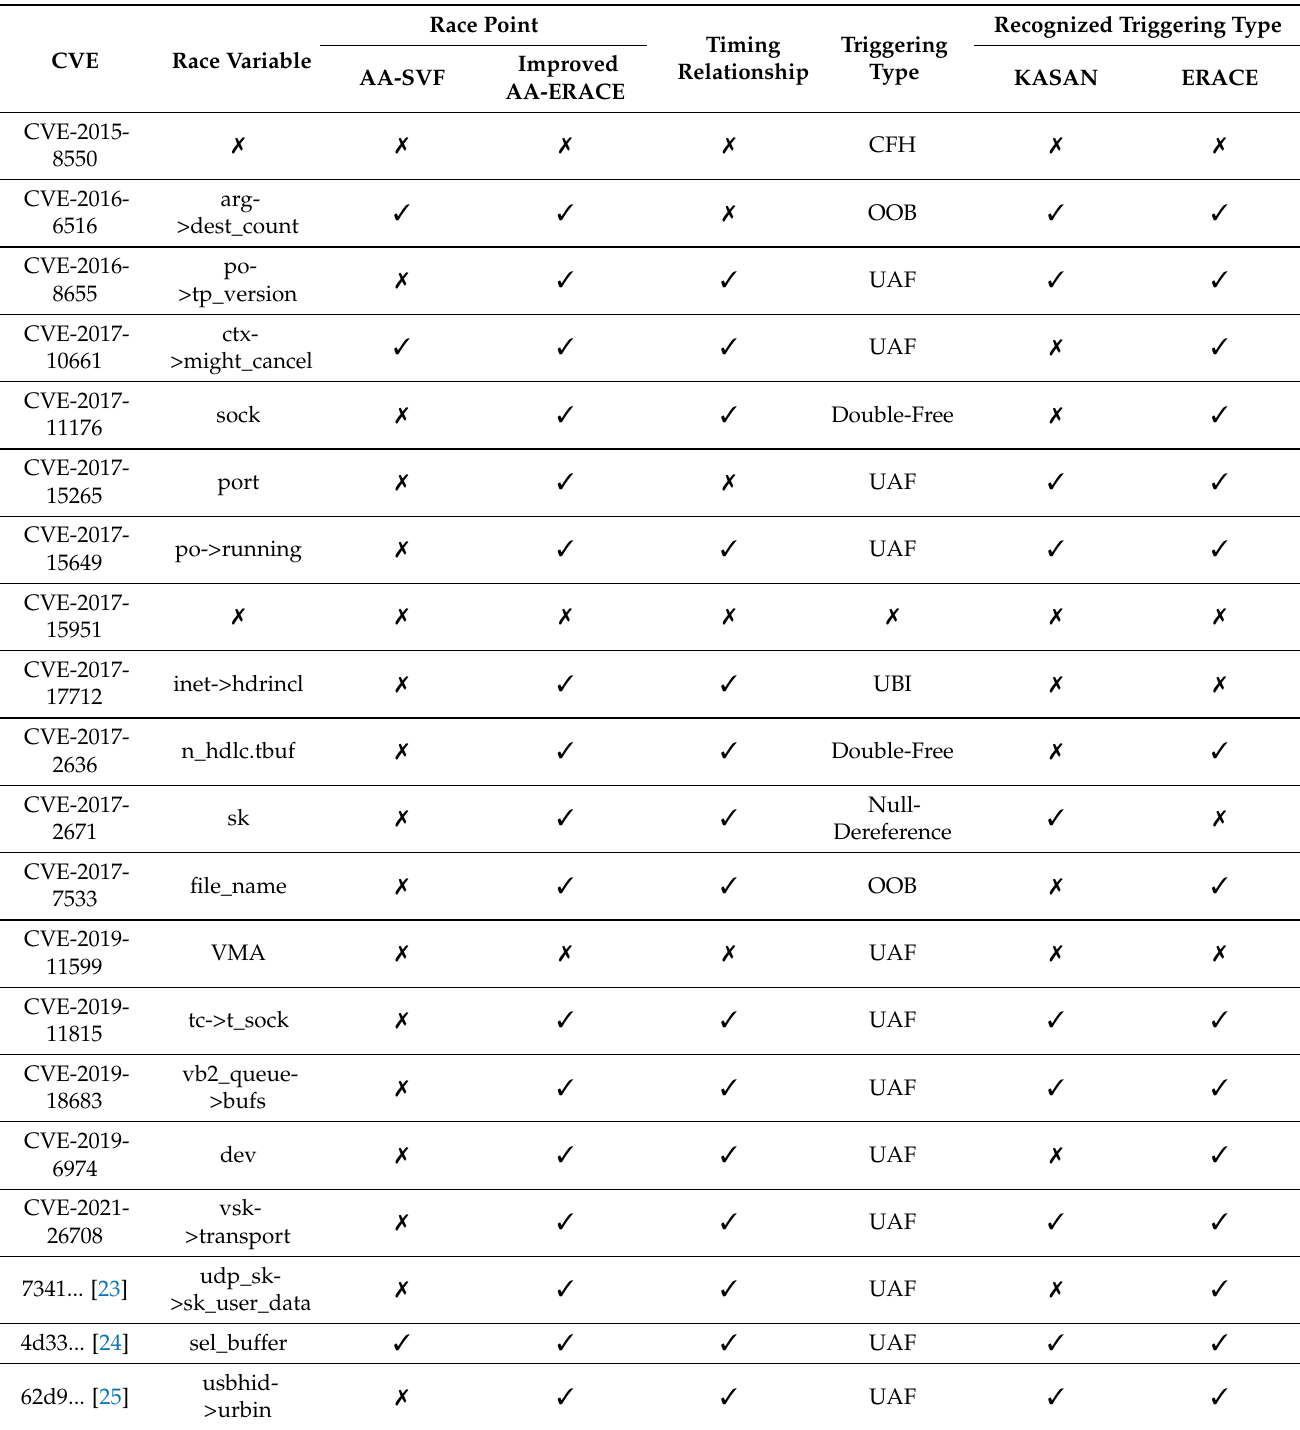
Table 1. Accuracy of ERACE . Race variable denotes the variable that race points read from or write to; AA- SVF indicates the use of traditional alias analysis of SVF ; Improved AA-ERACE indicates the use of relaxed alias analysis in ERACE ; Timing relationship stands for whether ERACE could recognize the true timing relationship of the race instructions; UBI denotes a use-before-initialization vulnerability. (cid:55) means it fails to identify, while (cid:51) means it succeeds in